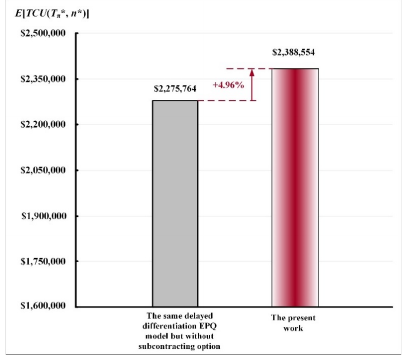
Fig. 13. Detailed expenses breakup of E [ TCU ( T π *, n